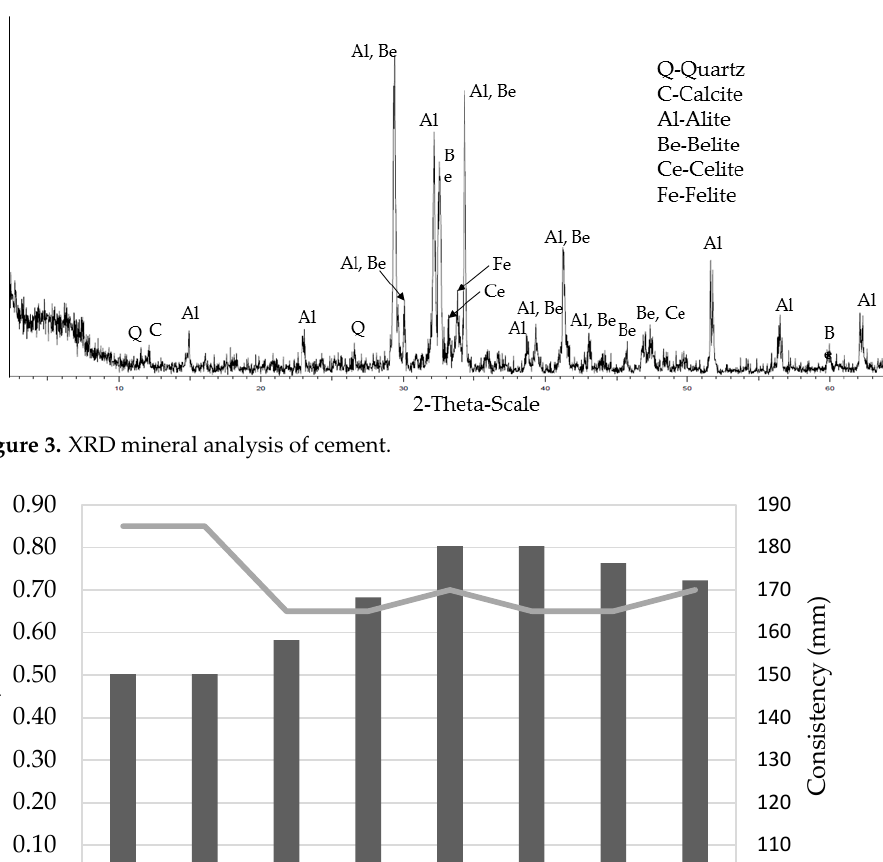
Figure 4. Water/cement ratio ( w / c ) and consistency of all mixtures.